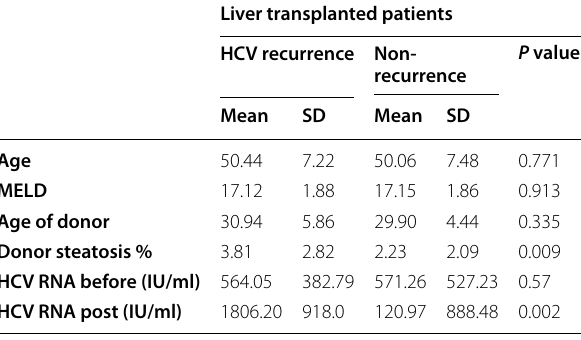
Table 6 Clinical features of the 106 recipients